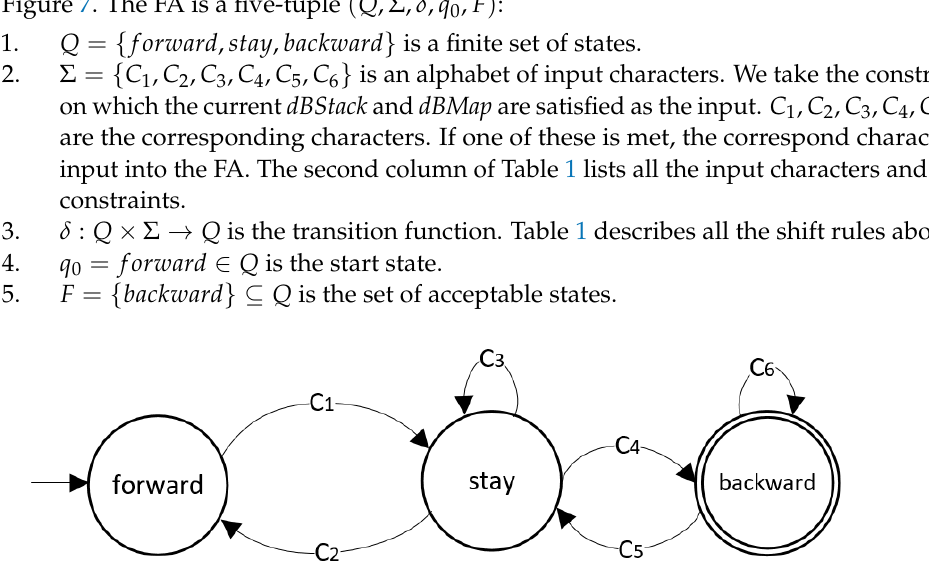
Figure 7. The FA is a five-tuple ( Q , Σ , δ , q 0 , F ) :